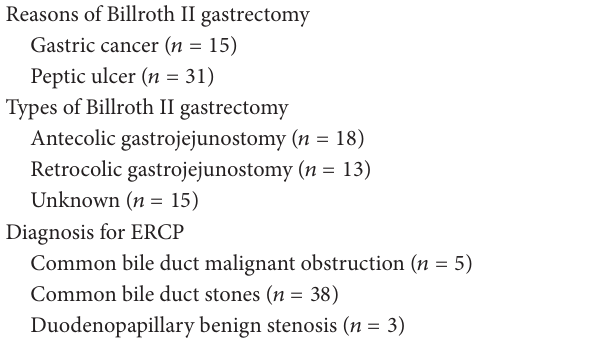
Table 1: Demographic and clinical characteristics of the recruited patients ( 𝑛 = 46